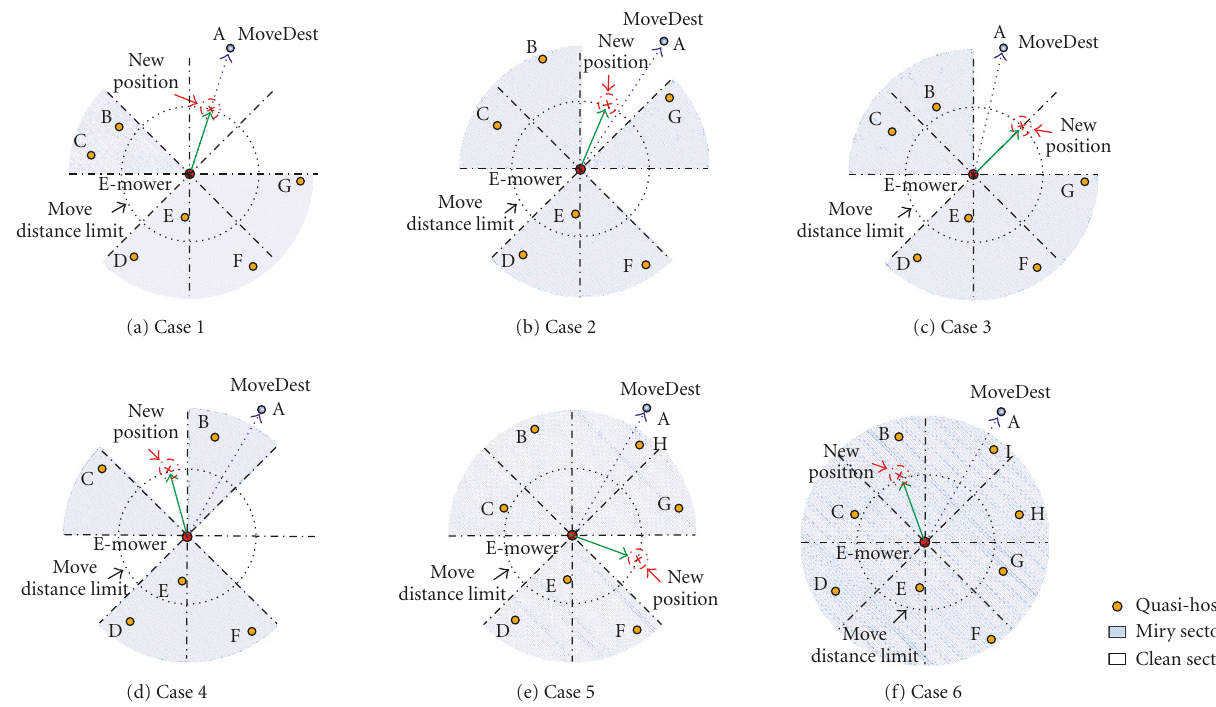
Figure 1: Six decision cases of the half-quadrant-based moving strategy. In each case, the blue node A is MoveDest, and the orange nodes are